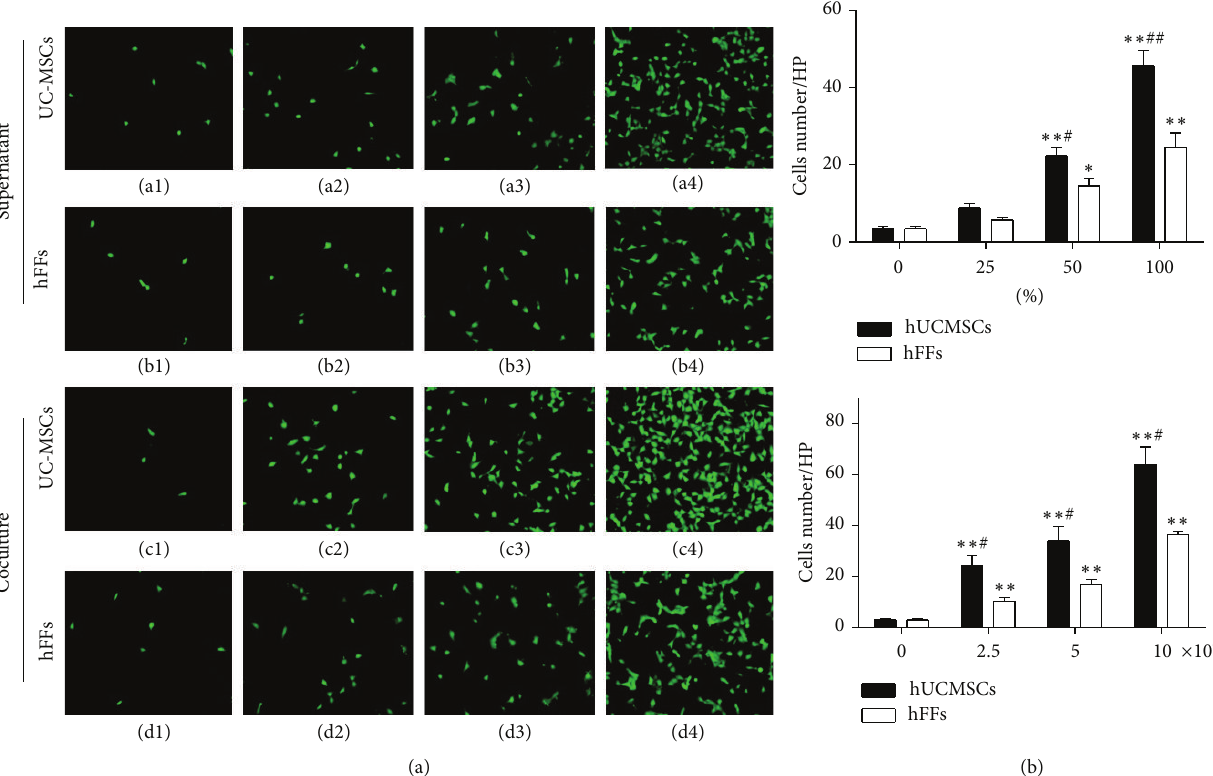
Figure 5: Effect of hUCMSCs and hFFs on the migration ability of HTR-8/SVneo trophoblast cells. (a) HTR-8/SVneo cells (2 × 10 4 cells/well) were cultured in medium containing 0, 25, 50, or 100% hUCMSC (a1–a4) or hFF (b1–b4) supernatant in Transwell inserts for 16 hours or were cocultured with hUCMSCs (c1–c4) or hFFs (d1–d4) at a concentration of 0, 2.5, 5, or 10 × 10 4 cells/well in Transwell inserts for 16 hours. Cells that had migrated were stained with calcein-AM. (b) HTR-8/SVneo cells that had migrated were counted after staining. ∗ represents significant differences versus control ( 𝑃 < 0.05 ); ∗∗ represents very significant differences versus control ( 𝑃 < 0.01 ); # represents significant differences between hUCMSCs and hFFs at an individual dose ( 𝑃 < 0.05 ); ## represents very significant differences between hUCMSCs and hFFs at an individual dose ( 𝑃 < 0.01